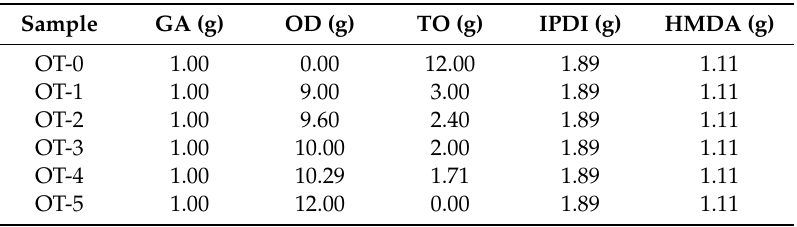
Table 1. The detailed recipes of the synthesis process of di ff erent antibacterial microencapsulated phase change materials